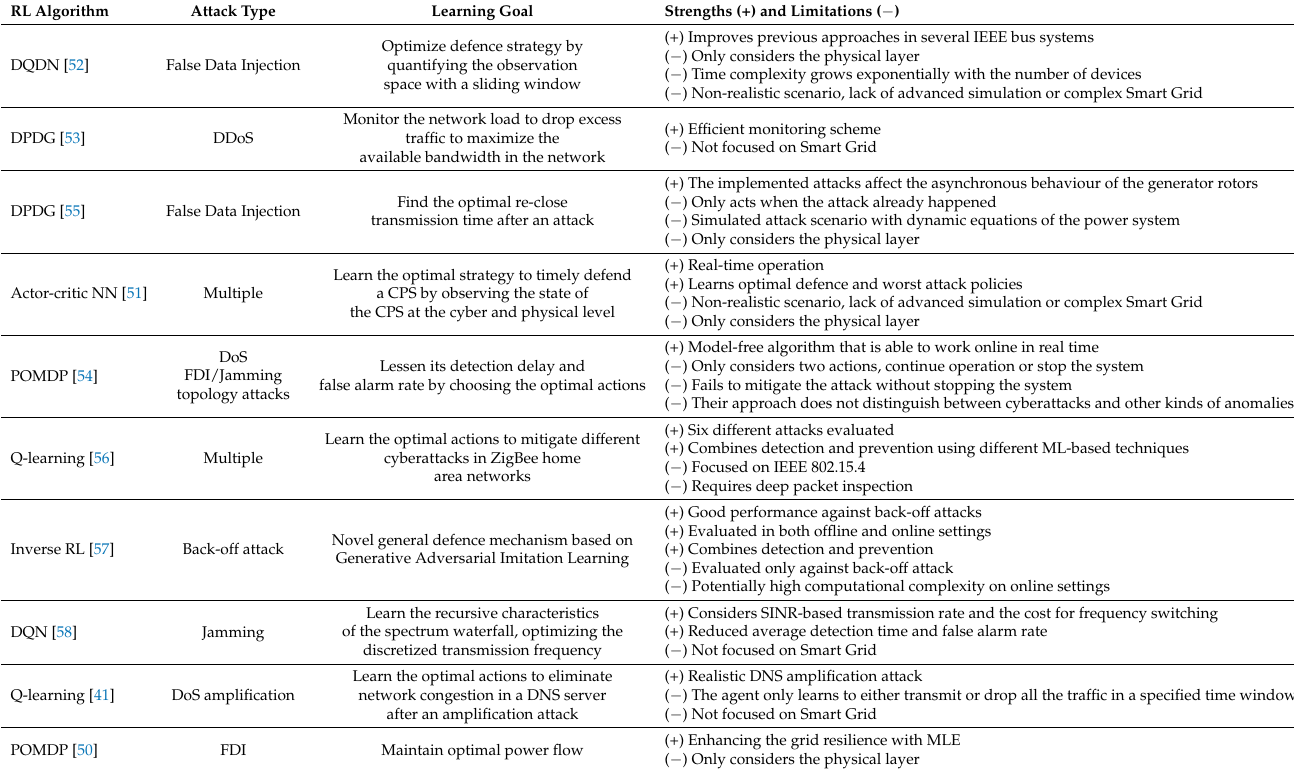
Table 2. Strengths and limitations of the discussed works on using RL to defend smart